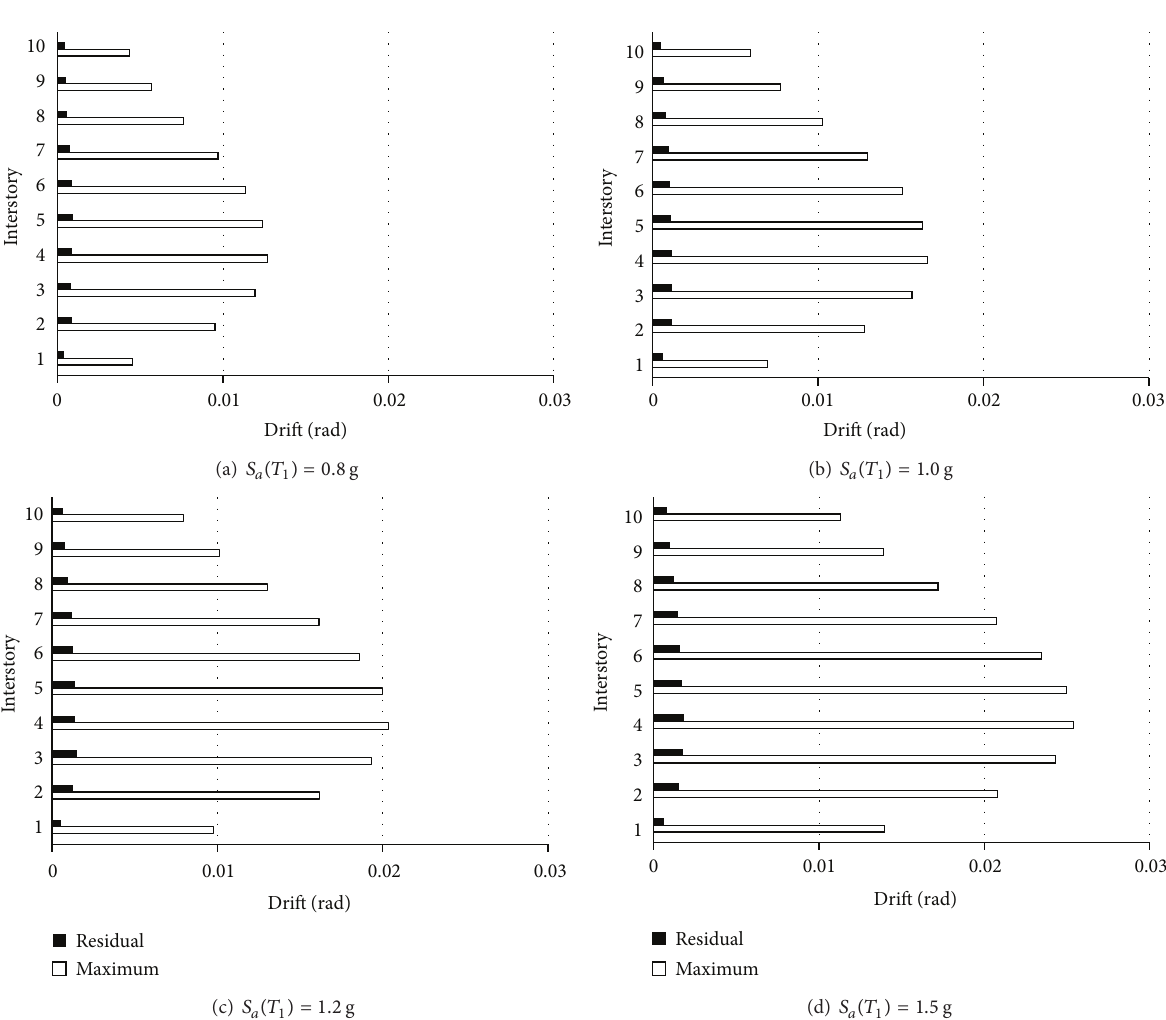
Figure 9: Median values of maximum and residual interstory drifts for F10PTC at different spectral acceleration values: (a) 0.8 g, (b) 1.0g, (c) 1.2g and (d)